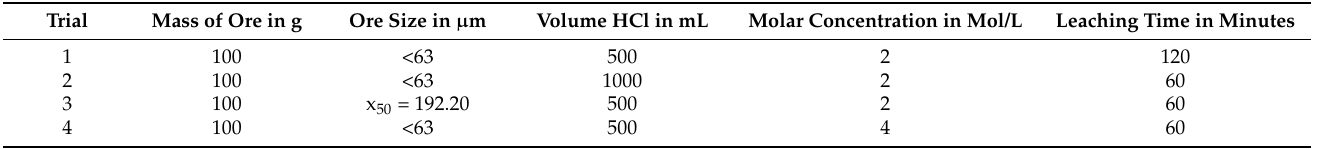
Table 3. Parameters of nonstandardized Fe 3+ -leaching trials.